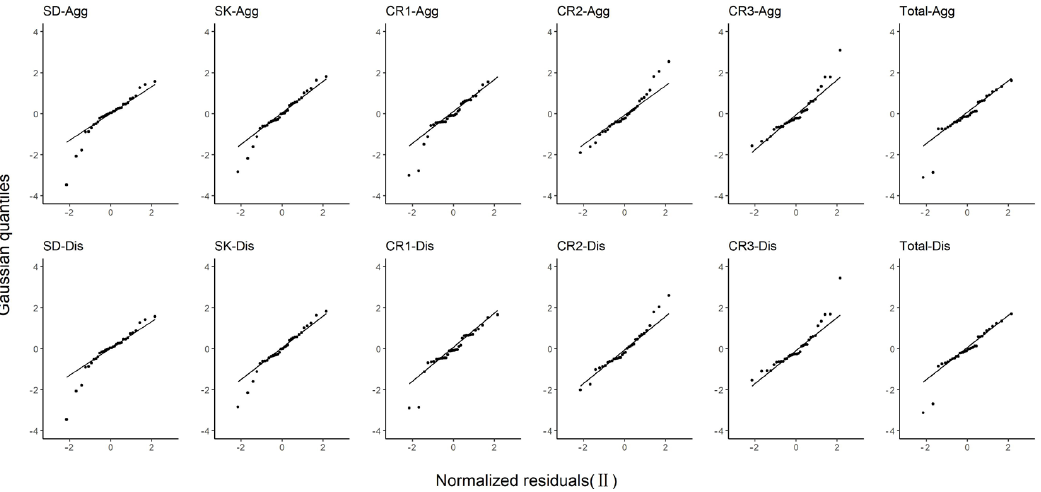
Figure 5. Gaussian probability plots of normalized residuals from the additive model and the disaggregated model for site class II.